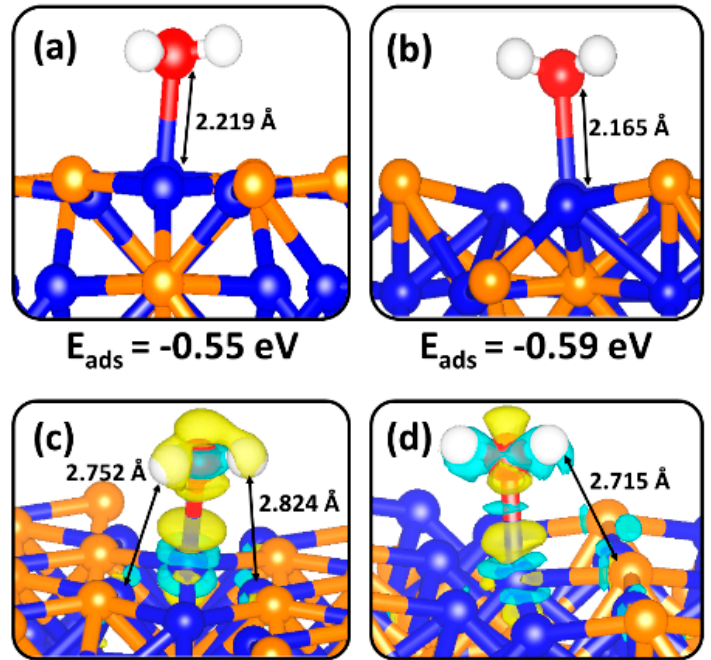
Table 1. Molecular adsorption energies (E ads ), bond lengths (d), bond angles ( α ), Bader charge of adsorbed water ( q (H 2 O)), and vibrational frequencies ( υ ) for water adsorption on Ni 2 P (0001) and (10 1(cid:3364) 0) surfaces. The gas phase O − H stretching modes are predicted at 3988 and 3866 cm − 1 .